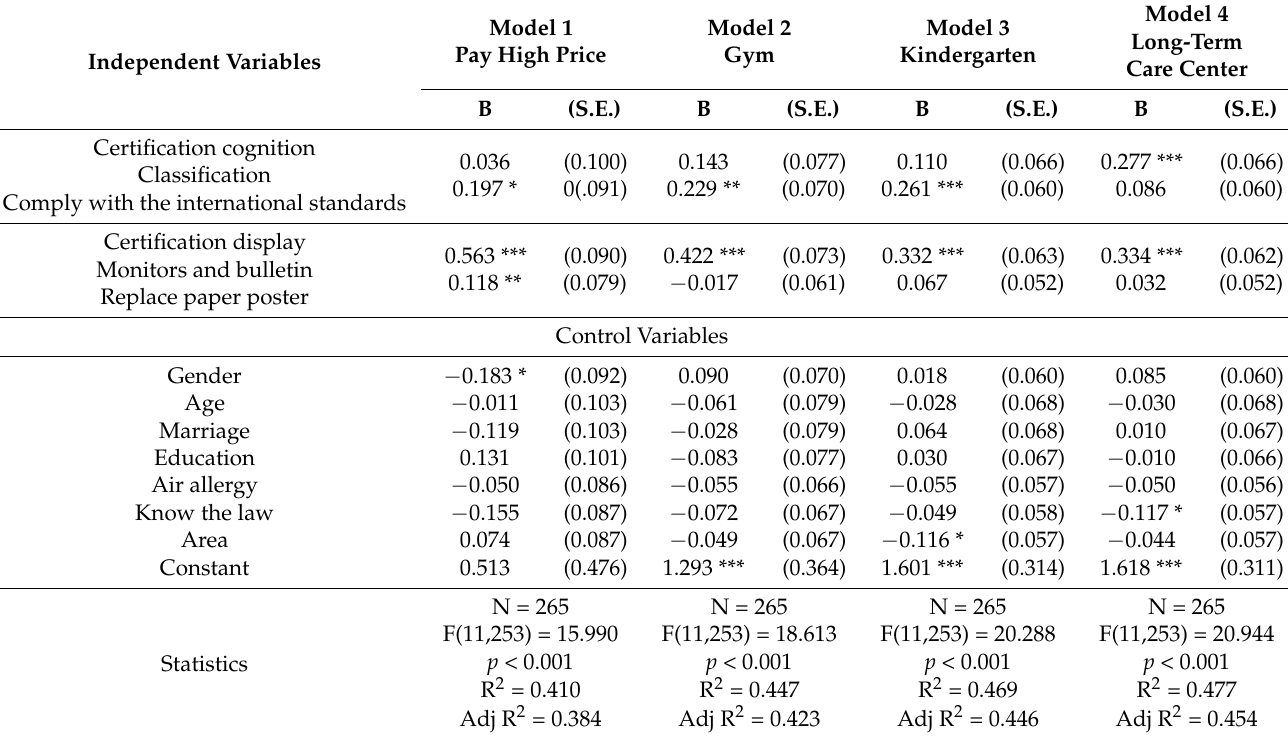
Table 11. Certification cognition and display